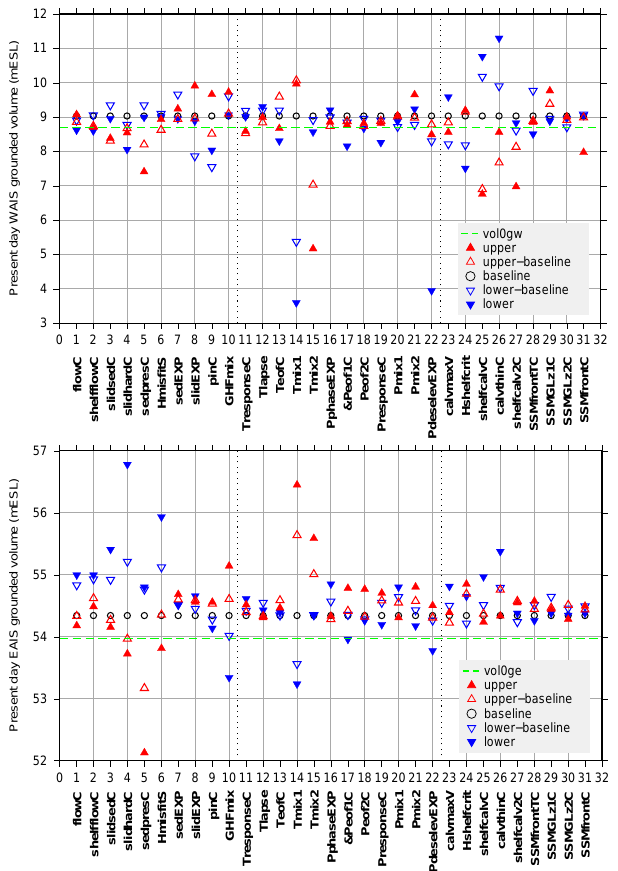
Fig. 8. Sensitivity results for present-day WAIS (upper) and EAIS (lower) grounded ice volume. The dotted lines segregate the pa- rameters into blocks pertaining to ice physics, climate forcing and ice–ocean forcing. Observational metrics values (dashed green line) are computed from H 40